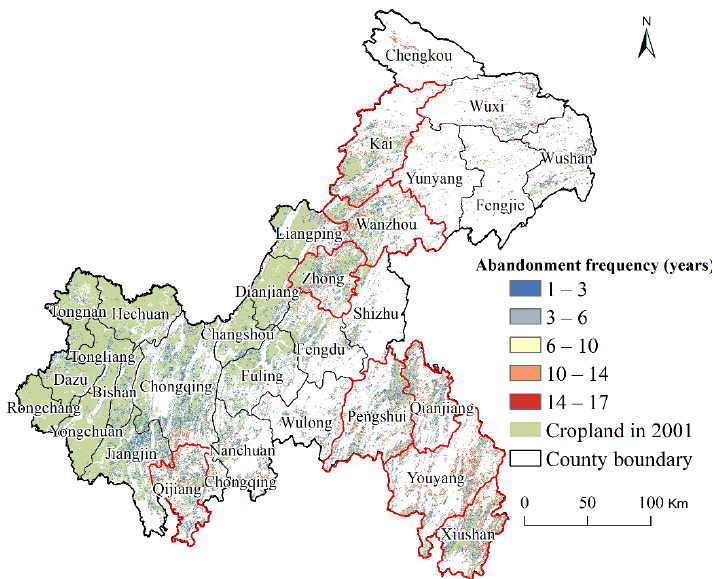
Figure 5. Distribution of cropland abandonment frequency in Chongqing from 2001 to 2020 . From 2001 to 2020, the cropland abandonment rate in most counties of Chongqing showed an increasing trend, whereas, in some areas, such as Chengkou and Wuxi, it